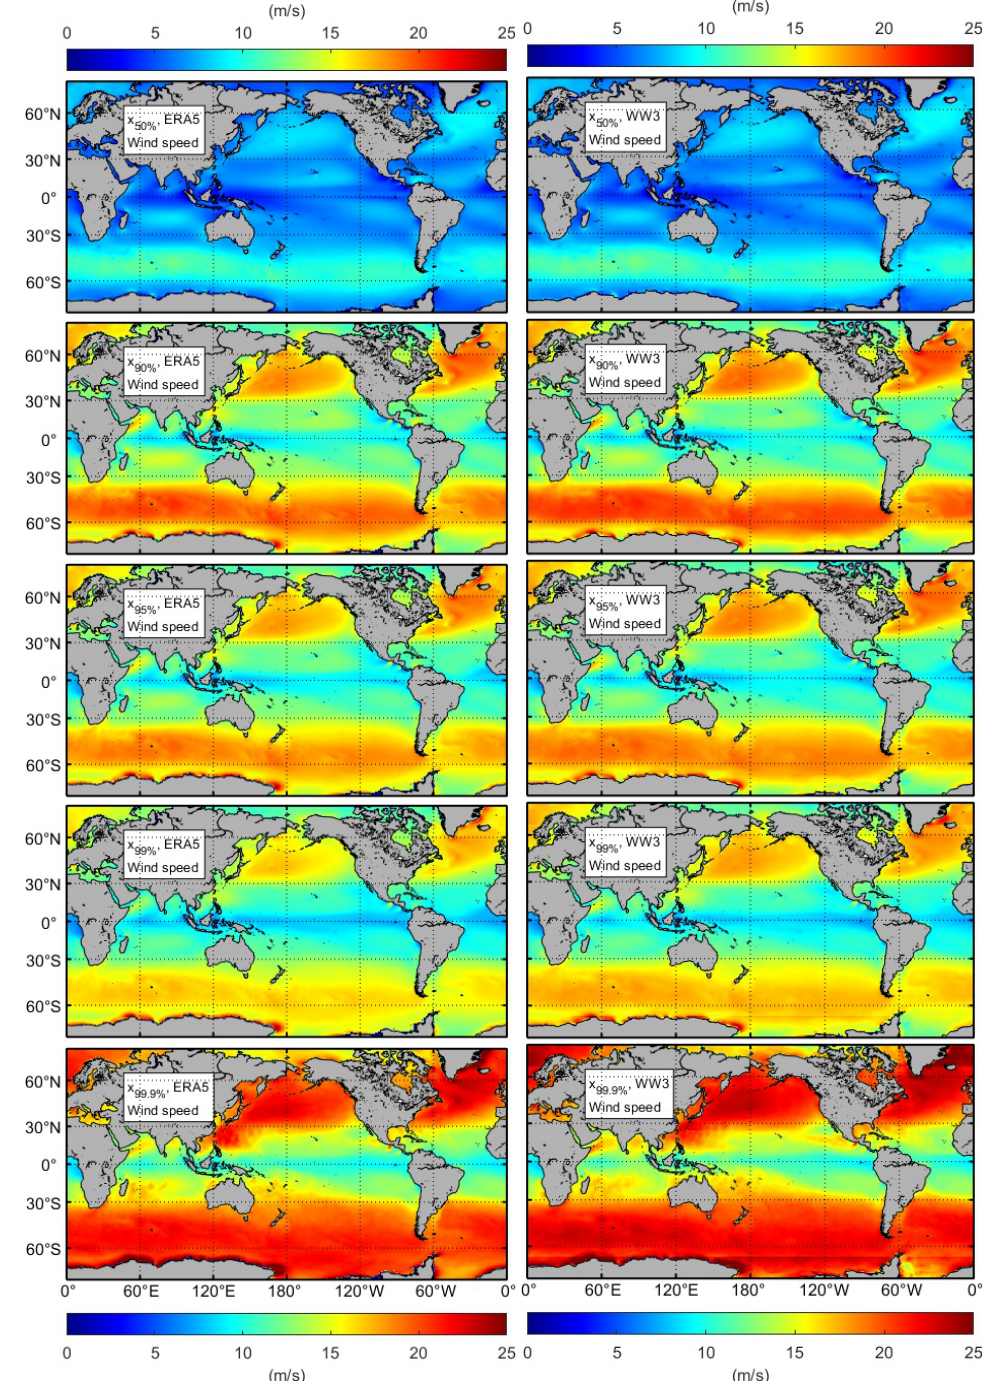
Figure 7. Mean annual fields of quantiles 50%, 90%, 95%, 99% and 99.9% of wind speed ( left : ERA5, right :